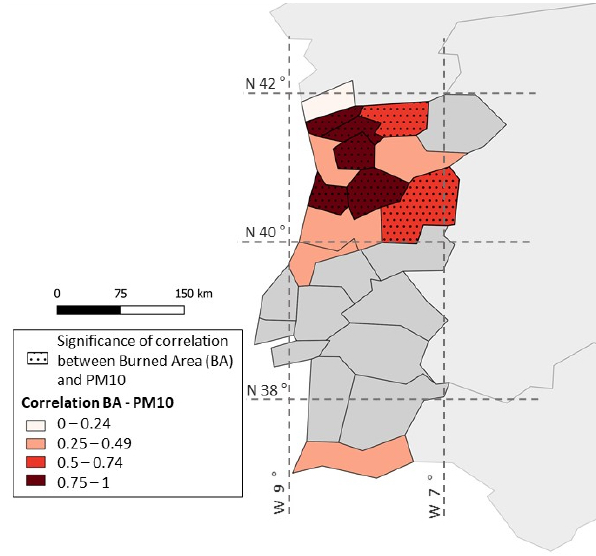
Figure 5. Significance of Pearson correlations between burned area and PM 10 for each NUTS III region in the period 2001–2016 (from June to September; dots represent significant correlations at 95%